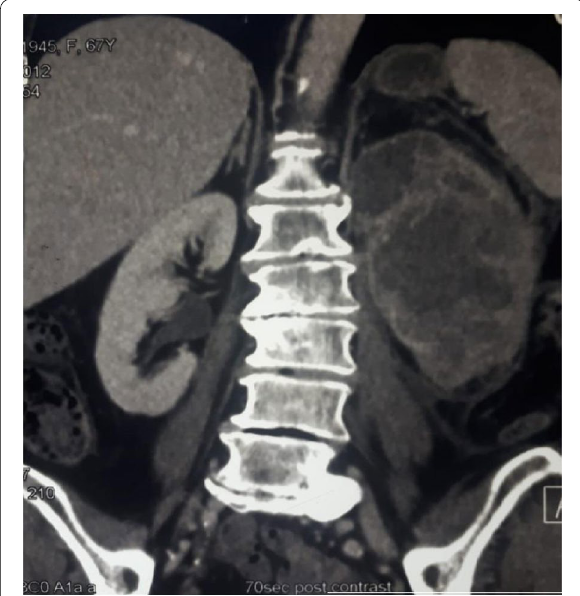
Fig. 1 A preoperative coronal CT section showing the mass